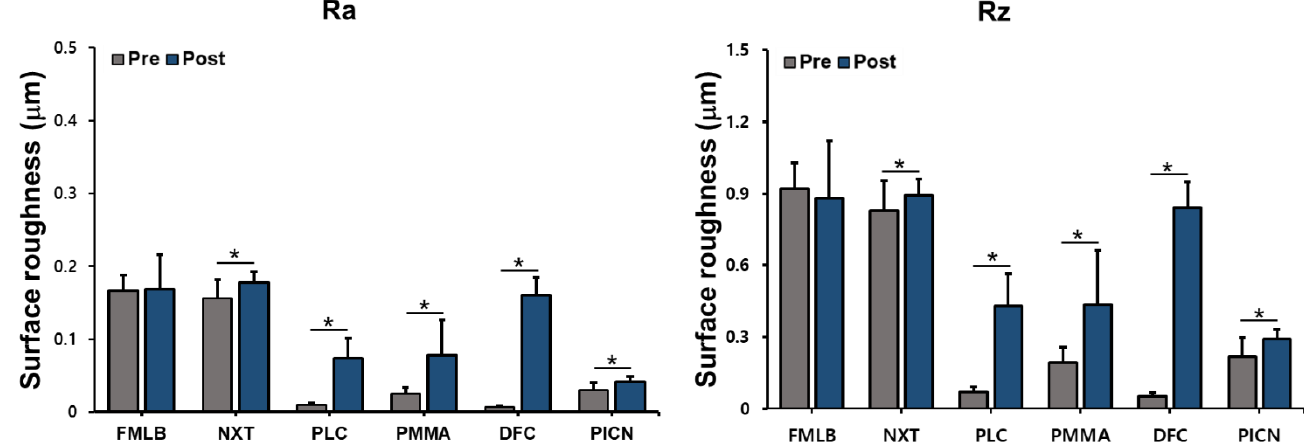
Figure 3. Surface roughness (Ra, Rz; data are mean and standard-deviation values) of six materials pre and post artificial toothbrushing. Asterisks indicate statistically significant differences ( p < 0.05).